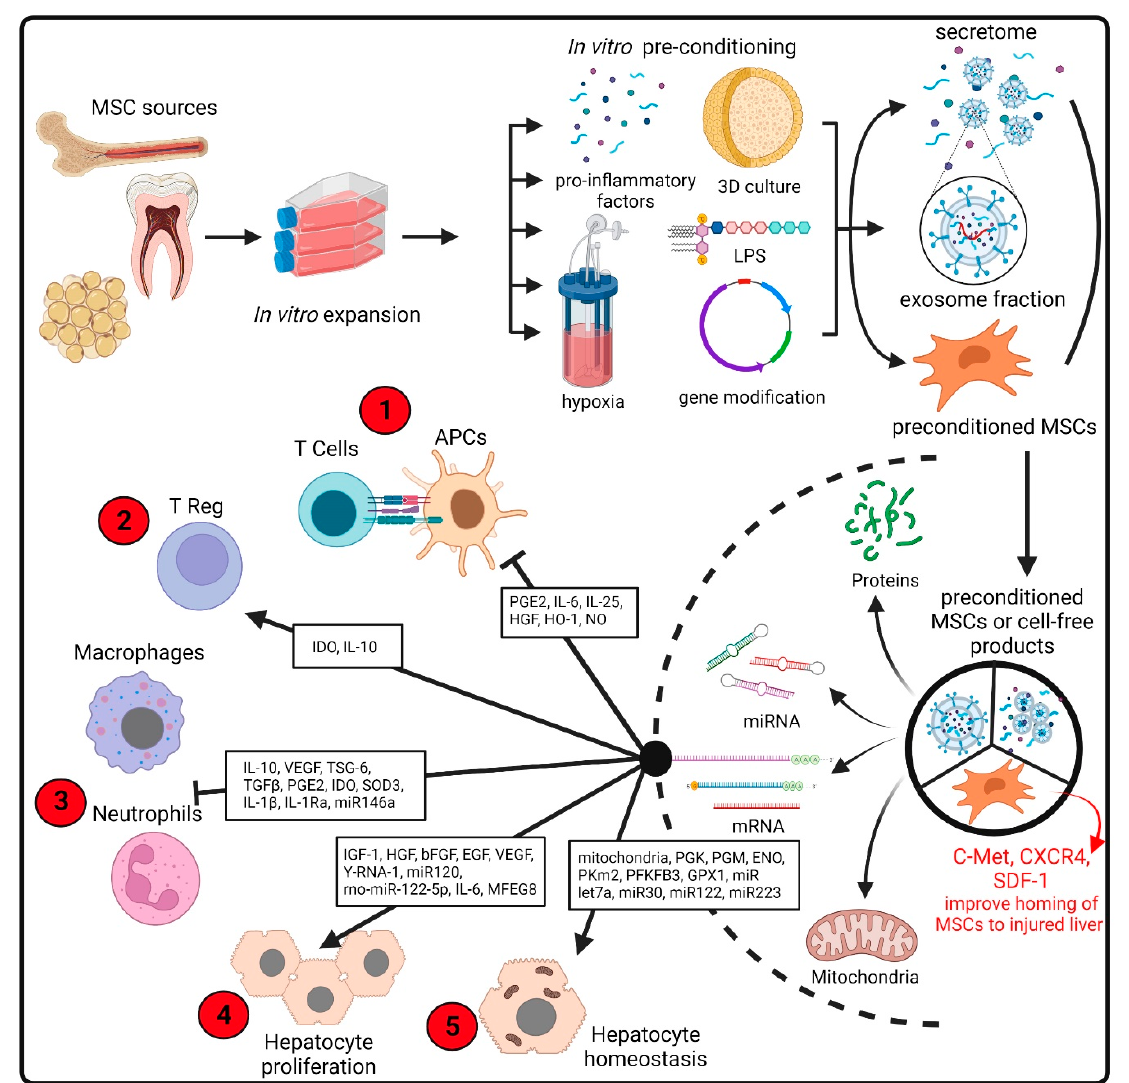
Figure 2. Comprehensive management of the production of improved MSCs for transplantation or cell-free products. Preconditioned MSCs or therapeutic products based on MCS secretome can be generated from stem cells isolated from common sources such as bone marrow, adipose tissue or dental pulps (among multiple sources). The cells are expanded in culture, followed by in vitro pre- conditioning (including treatment with cytokines, drugs, 3D cultures and hypoxic environment) to enhance the production of key molecules in the pathogenesis of liver disease. In addition to MSC pretreatment, gene modification is also used to improve the therapeutic effects of MSCs in liver diseases [63]. The secretome is subsequently collected and subjected to procedures intended to re- move the cellular components. This secretome comprises soluble proteins and secreted extracellular vesicles. Both MSCs and cell-free products have a wide range of therapeutically beneficial effects mediated by the biological activity of a diverse range of proteins, lipids or RNA molecules [127]. The therapeutic properties include immunoregulatory activities on multiple innate and adaptive cells [28] and the secretion of a broad spectrum of angiogenic and mitogenic factors that stimulate hepatocyte proliferation [33]. Recently, the transfer of mitochondria from MSCs to damaged cells has been proposed [123]. The red circles indicate the DILI pathological events that may be moder- ated by MSC administration (see Figure 1). bFGF: basic fibroblast growth factor; CXCR4: C-X-C motif chemokine receptor 4; EGF: epidermal growth factor; ENO: enolase; GPX1: glutathione pe- roxidase 1; HGF: hepatocyte growth factor; HO-1: heme oxygenase 1; IDO: indoleamine 2,3-dioxy- genase; IGF-1: insulin-like growth factor 1; IL1Ra: interleukin 1 receptor antagonist; LPS: lipopoly- saccharide; MFG8: milk fat globule EGF factor 8 protein; NO: nitric oxide; PGE2: prostaglandin E2; PGK: phosphoglycerate kinase; PGM: phosphoglucomutase; PFKFB3: 6-phosphofructo-2-ki- nase/fructose-2,6-biphosphatase 3; PKm2: pyruvate kinase m2 isoform; SDF-1: stromal cell-derived